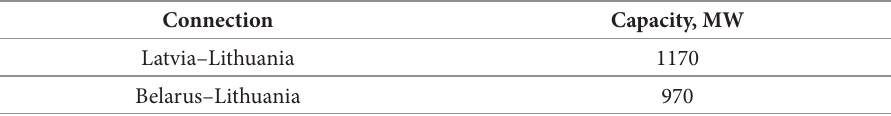
Table 2. Maximum potential capacity flows with neighbourhood